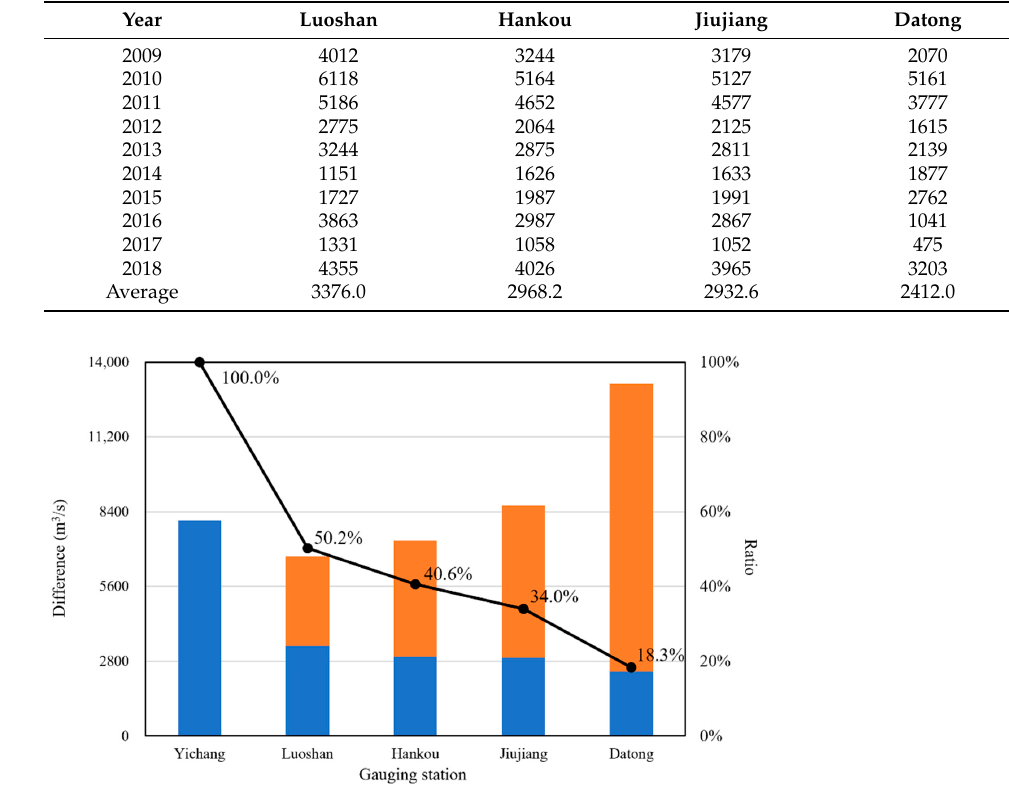
Table 4. The difference between the reconstructed maximum 1-day discharge and the observed maximum 1-day discharge at the Yichang gauging station was routed to the four gauging stations downstream from the Yichang gauging station by using the Muskingum model. If the difference is greater than 0, the TGD has reduced the maximum 1-day discharge during flood season.